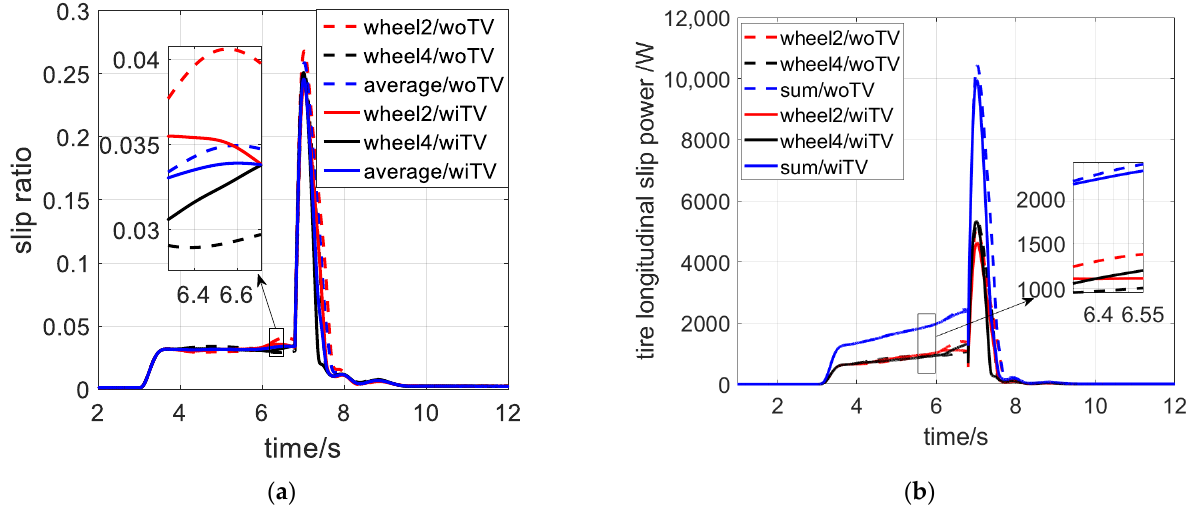
Figure 14. The double lane change maneuvering simulation: ( a ) slip ratio; ( b ) tire slip power.